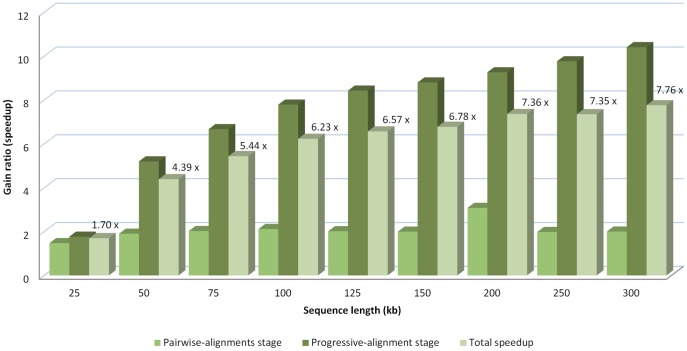
Speedup of the MC64-ClustalWP2 against ClustalW-MPI.The speedup is shown both for each relevant stage and for the full execution when aligning sets of ten randomly-generated sequences of different sizes.